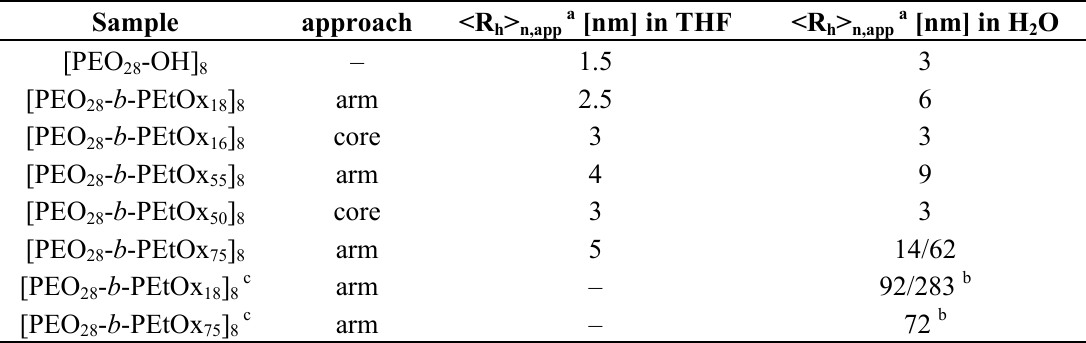
Table 3. Determination of the apparent hydrodynamic radius (<R (block co-) polymer systems in non-selective solvents via